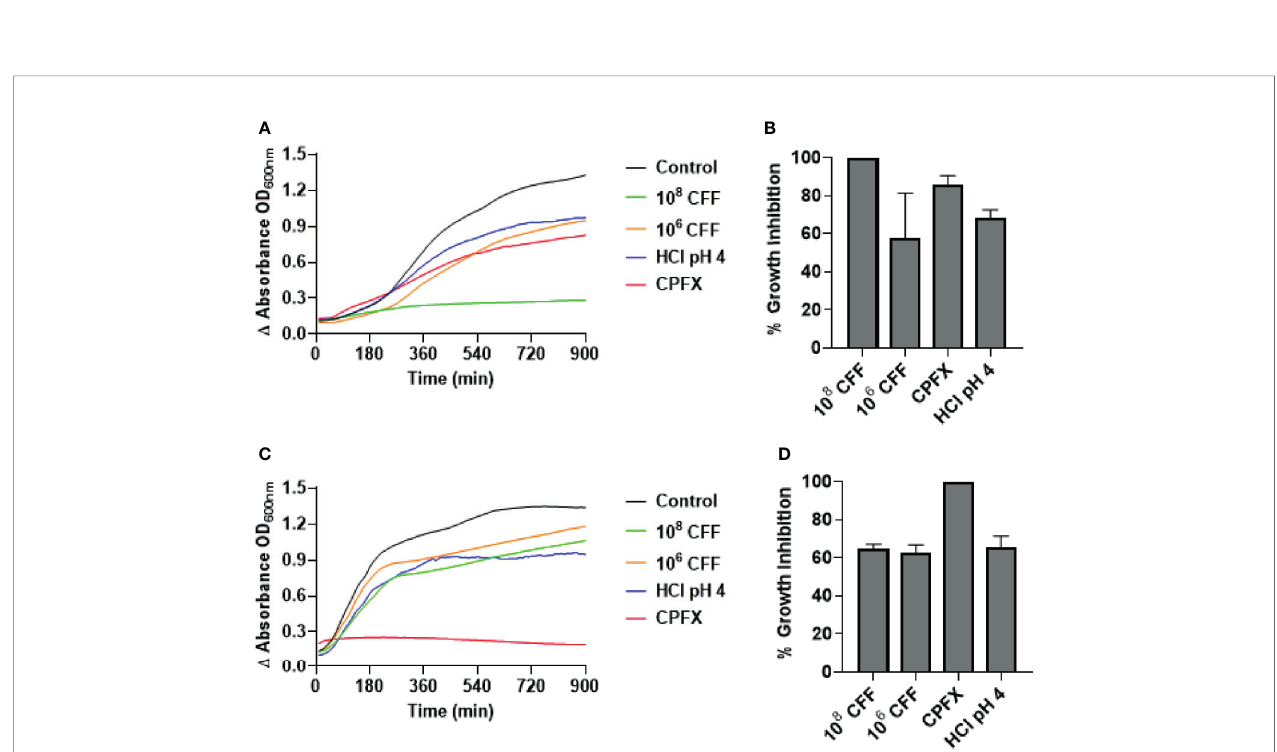
FIGURE 4 | L. acidophilus cell free fi ltrate (CFF) exhibits bactericidal action on P. aeruginosa planktonic cell growth but not on E. coli growth. Growth curves were conducted by incubating P. aeruginosa or E. coli in a 96-well plate with L. acidophilus 10 8 or 10 6 CFF, 1 µg/mL cipro fl oxacin (CPFX), or HCl pH 4 at 37°C with orbital shaking. Absorbance (OD 600 ) was measured every 10 min for 20 h. (A) L. acidophilus 10 8 CFF completely inhibited P. aeruginosa planktonic growth (p < 0.001). 10 6 CFF, HCl pH 4, and 1 µg/mL cipro fl oxacin affected P. aeruginosa growth, although signi fi cantly less effective than 10 8 CFF. (B) At the end of growth curve studies, bacteria were spread on TSA plates and colonies counted. 10 8 CFF killed > 99.99% P. aeruginosa and therefore was bactericidal. However, all other treatments were not bactericidal. (C) Both concentrations of L. acidophilus CFF and HCl pH 4 did not signi fi cantly inhibit E coli growth. However, 1 µg/mL cipro fl oxacin inhibited E. coli growth (p < 0.001). (D) Following growth curve studies, E . coli cells were spread on TSA plates and colonies counted. Only 1 µg/mL cipro fl oxacin was bactericidal (> 99.99% inhibition). P. aeruginosa growth curves n = 5 independent experiments; P. aeruginosa CFUs n = 3 independent experiments; E. coli growth curves n = 4 independent experiments; E. coli CFUs n = 3 independent